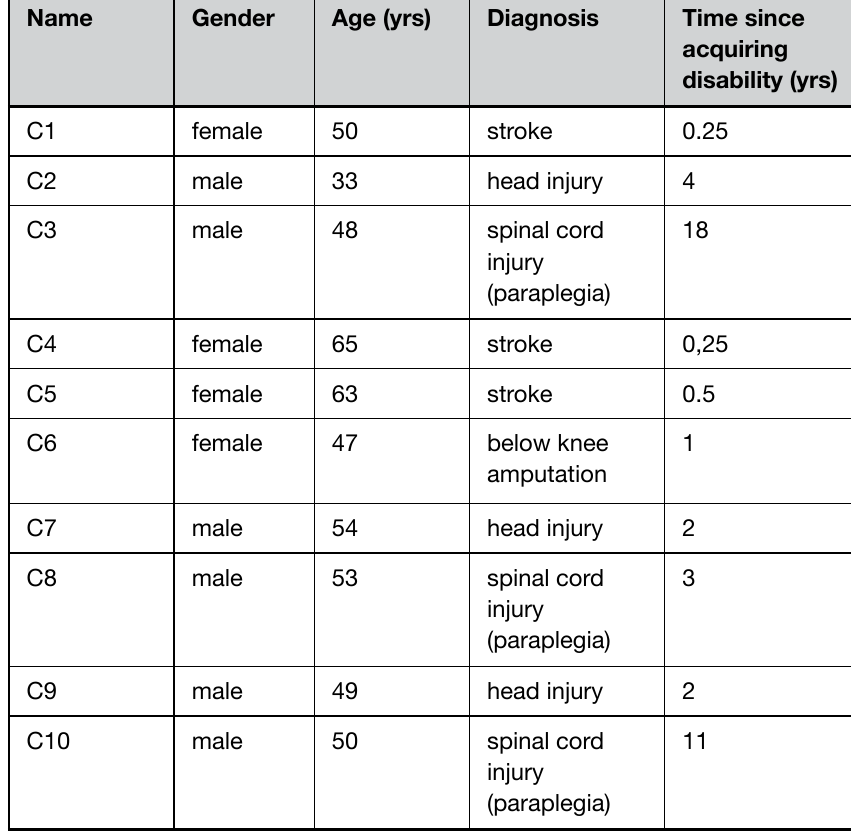
Table 1: Participants’